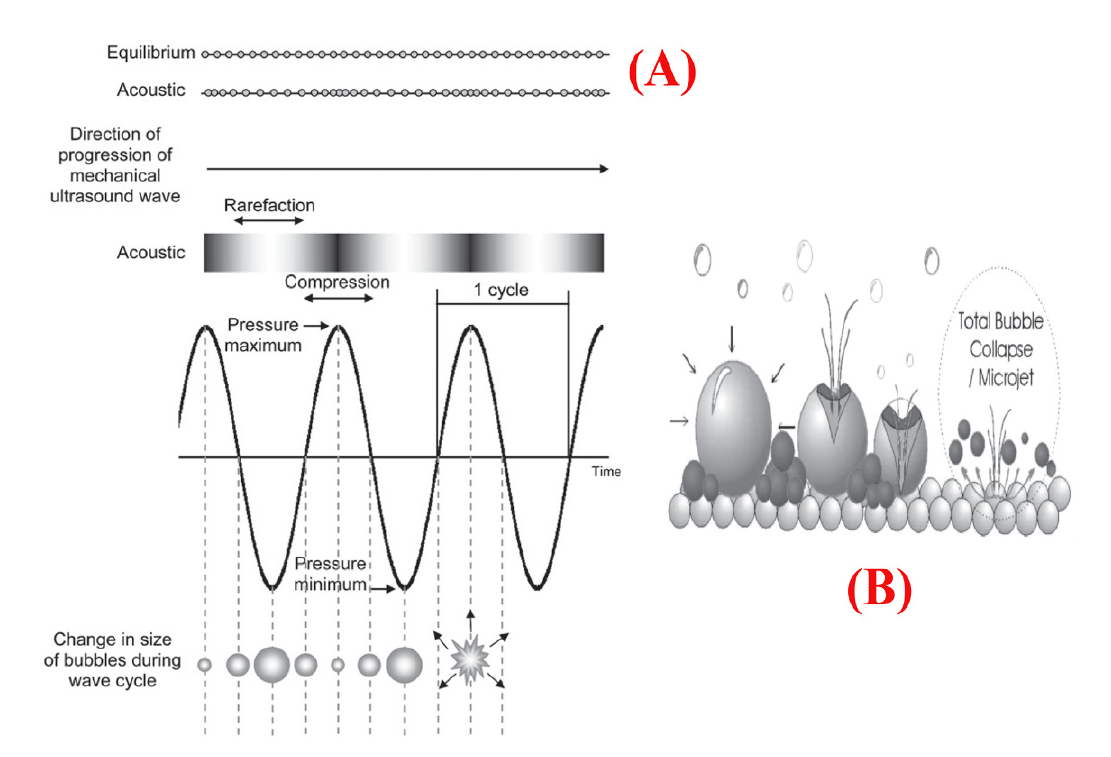
Figure 2. (A) Development and collapse of cavitation bubbles, and (B) schematic depicting classically thought bubble collapse at the solid surface (reproduced with permission of Elsevier and RSC-modified [